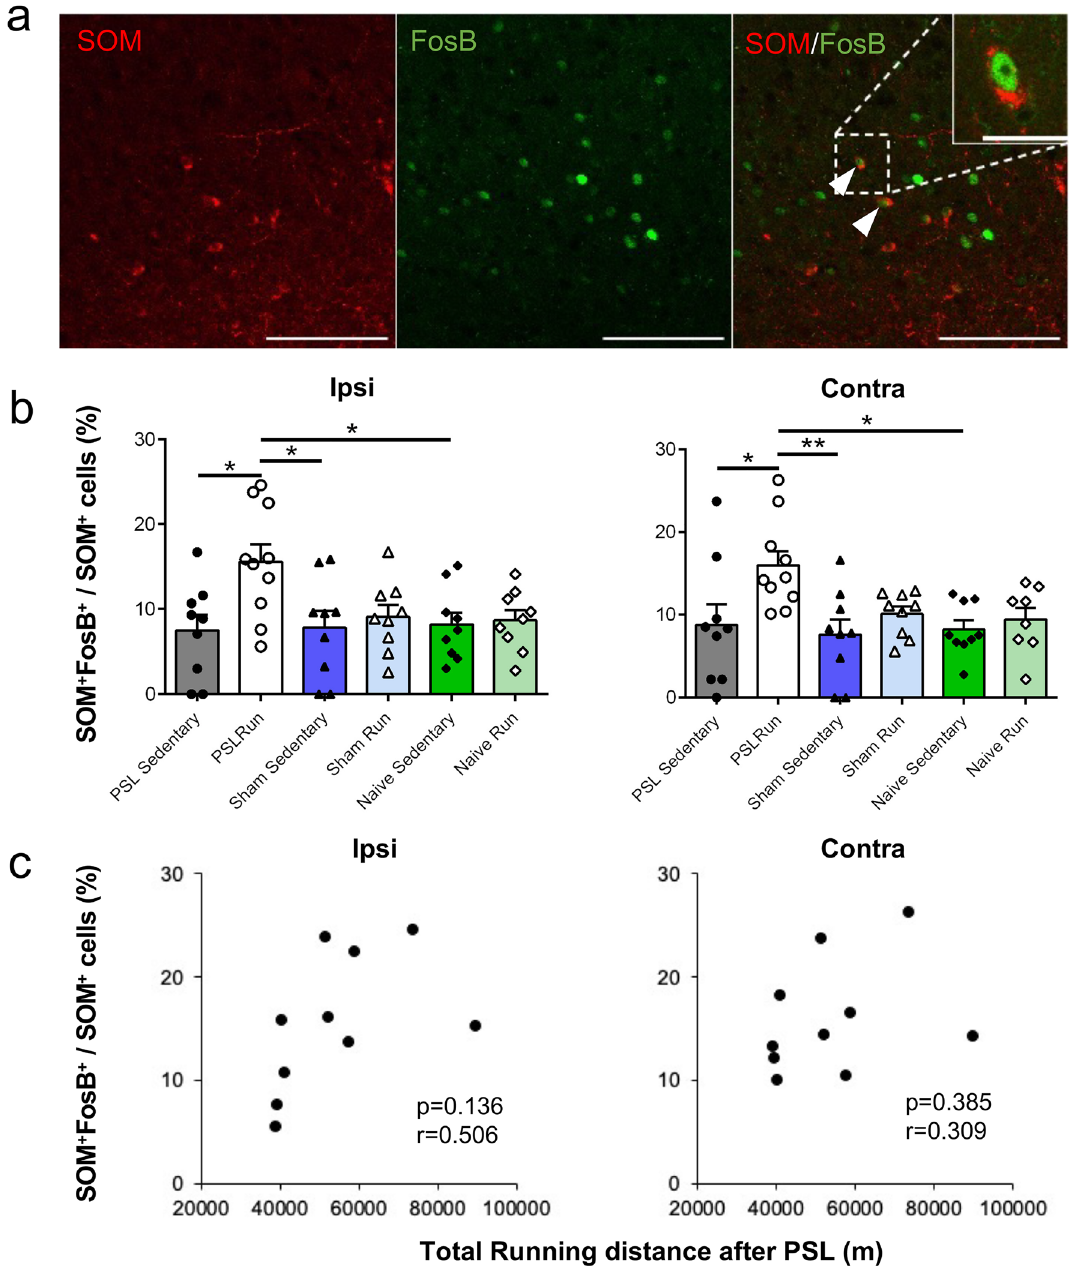
Figure 6. Voluntary running induces activation of SOM + interneurons in the vHPC-CA1. ( a ) Representative photomicrographs showing SOM (red) and FosB (green) immunoreactivities in the vHPC-CA1 in PSL-Runner mice. Many SOM + FosB + neurons (arrowheads) were detected in PSL-Runner mice. Scale bar = 100 mm. An enlarged SOM + FosB + neuron is shown in the left upper corner. Scale bar = 25 mm. ( b ) Bar charts showing the proportion of SOM + FosB + cells in the vHPC-CA1. The proportion of SOM + FosB + cells in PSL-Runner mice was significantly higher than other groups. Bars represent mean ± SEM. A two-way analysis of variance followed by Tukey’s post hoc-test was used to compare the proportion of PV + FosB + cells among the experimental groups. *p < 0.05, **p < 0.01. ( c ) Relationship between the proportion of SOM + FosB + cells and total running distance after PSL surgery in PSL-Runner mice. No significant correlation was observed on the ipsilateral side (p = 0.136, r = 0.506, n = 10) or the contralateral side (p = 0.385, r = 0.309, n = 10). PSL partial sciatic nerve ligation, SEM standard error of the mean, vHPC ventral